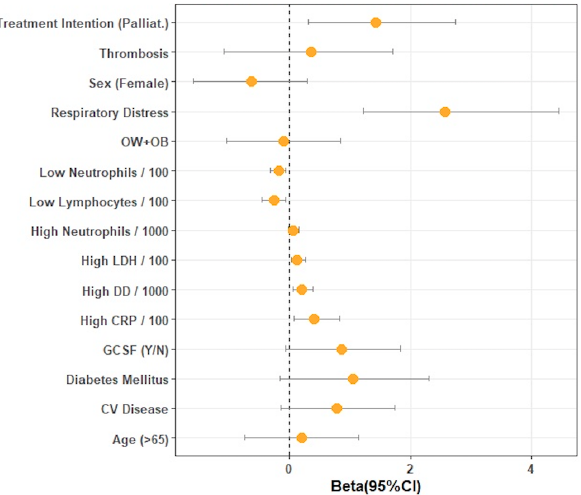
Figure 3. Forest plot showing mortality according to different variables related to neutropenia se- verity, treatment, and infection with COVID-19.